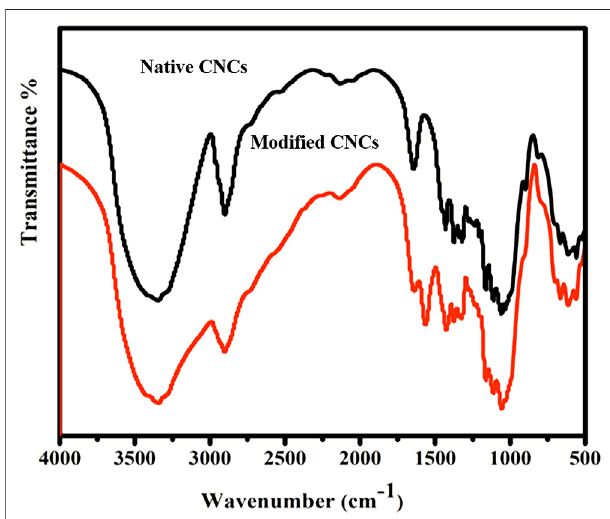
FIGURE 5 | FTIR spectra of native and modi fi ed CNCs.